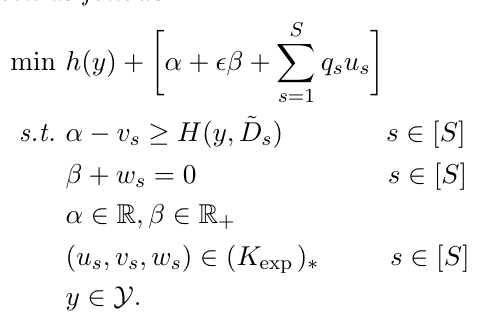
Algorithm 1. Input: A probability